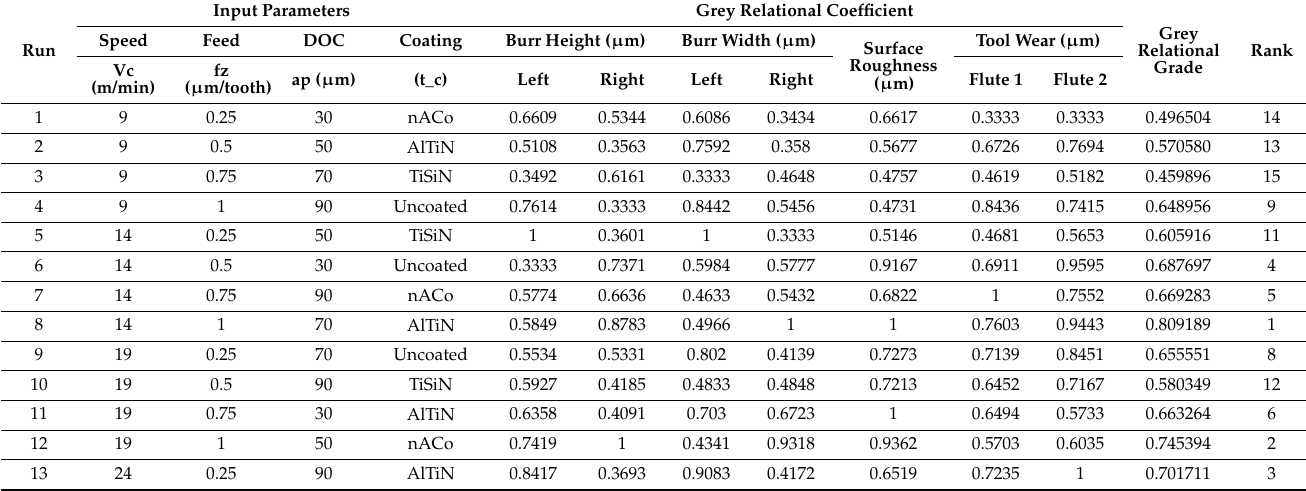
Table 5. GRG values for burr formation, tool wear, and surface roughness; and GRG for each